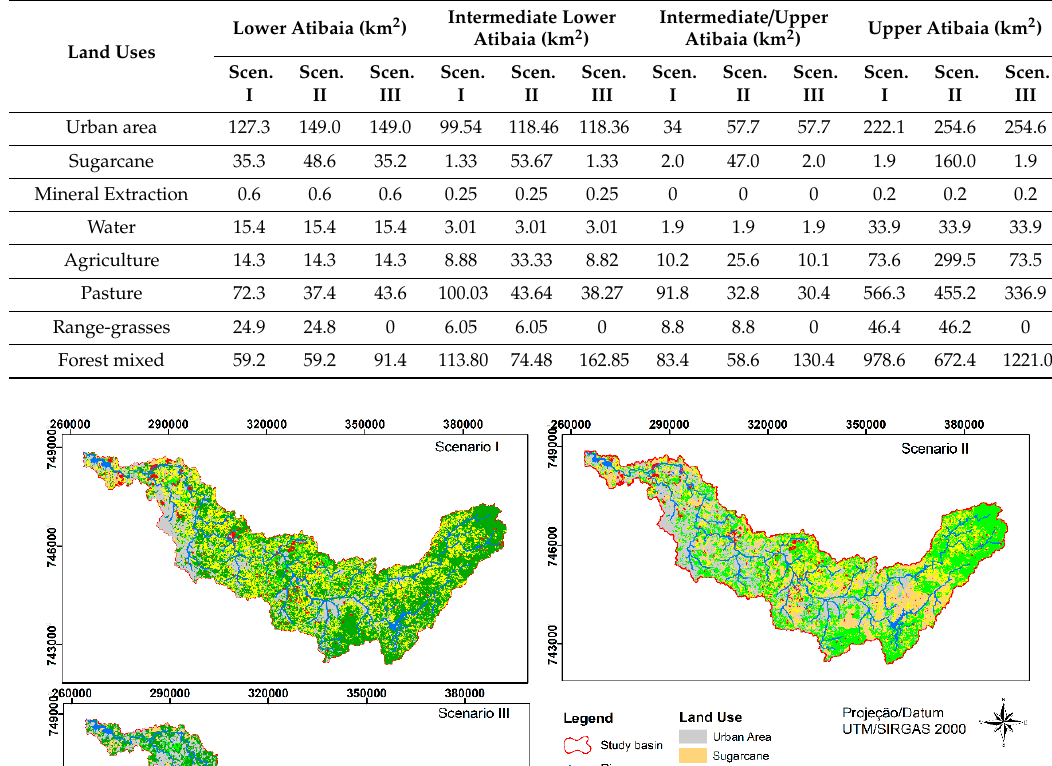
Table 2. Land use areas related to each scenario and sub-basin.